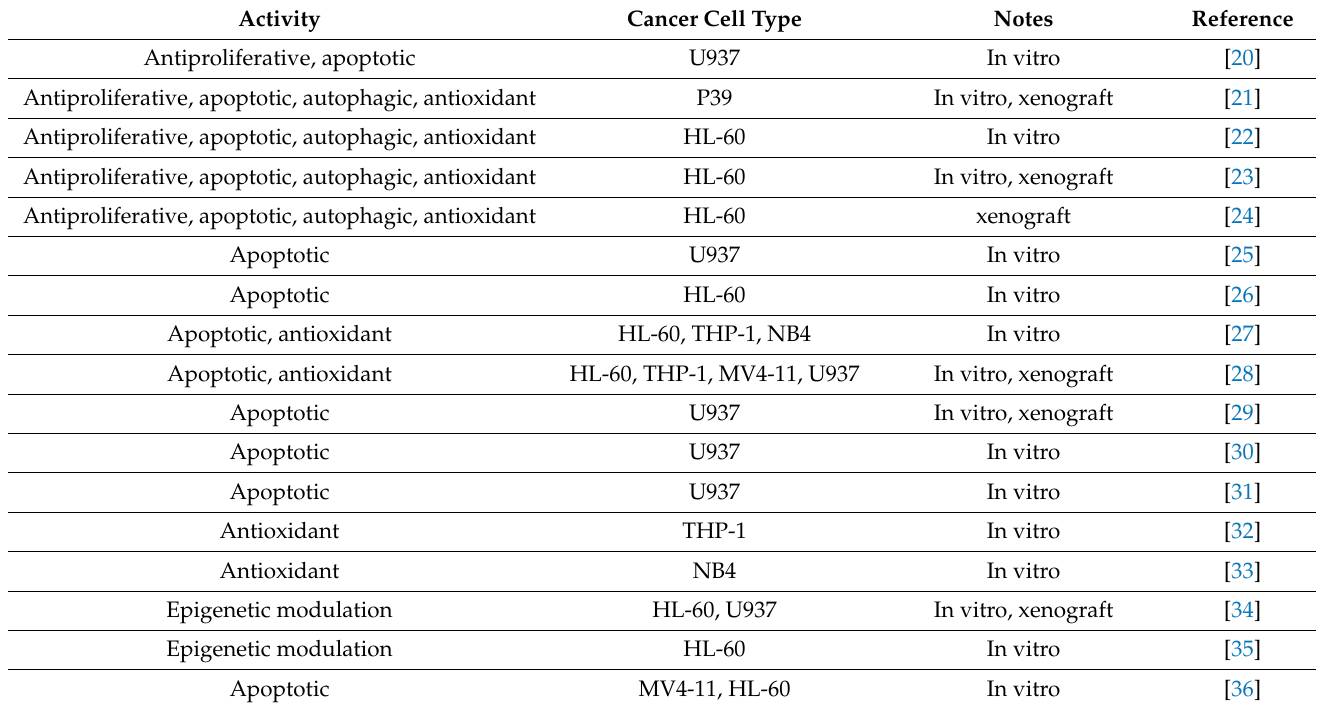
Table 1. Summary of activities for quercetin in AML and